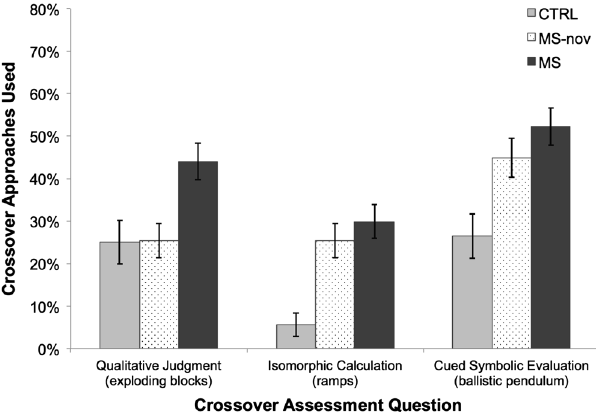
FIG. 3. Percentage of calculation-concept crossover approaches used in the three instructional groups on the crossover assess- ments. Error bars represent (cid:2) 1 SEM, calculated from the binomial